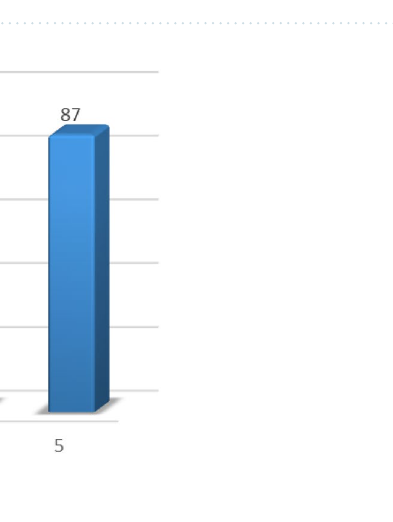
Figure 11. The proposed mechanism for the synthesis of 1,2,3-triazoles in the presence of Fe 3 O 4 @HKUST-1 Cu catalyst.